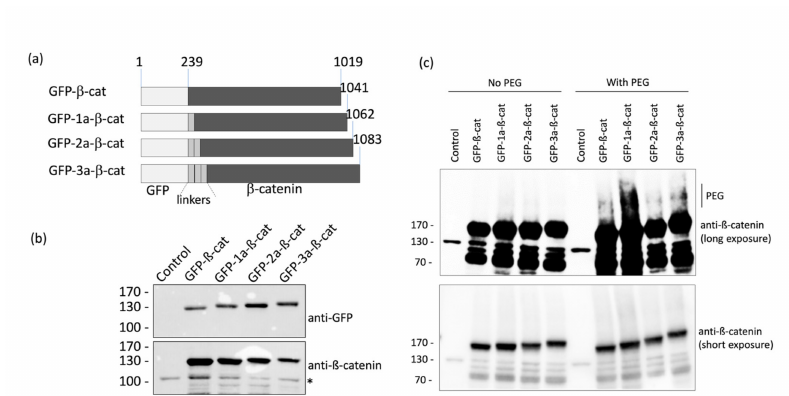
Figure 2. Design and validation of fluorescent β -catenin fusion proteins. ( a ) Schematic representation of the di ff erent GFP- β -catenin constructs used in this study. ( b ) HeLa cells were transfected with the various GFP- β -catenin expressing vectors. Cell lysates were analyzed by western blots using anti-GFP and anti- β -catenin antibodies. The asterisk indicates the detection of the endogenous form of β -catenin. ( c ) Protein extracts of HeLa cells were labeled with 4.4 kDa DBCO-PEG mass tag or incubated with DMSO. β -catenin proteins were detected by Western